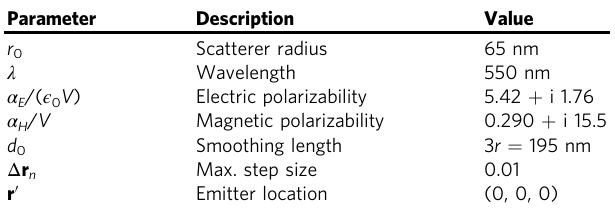
Fig. 1 The system considered in our numerical examples. A schematic of the problem is shown in ( a ). A dipole emitter with polarisation ^ p is located at r ′ . This generates source fi elds ( E s , H s ), which are scattered by N silicon spheres located at r n . The scatters have optical properties shown in ( b ). The scatterers are assumed to be isotropic silicon spheres of radius 65 nm, with the frequency dispersion of the polarizability extracted from experimental data 57 . A simple example of the design process is shown in ( c ). The power emission of the emitter (red arrow) is enhanced by iteratively moving passive scatterers (black dots). Colour plots show Im ½ E ð r Þ (cid:5) ^ p (cid:3) , which evaluated at the emitter ’ s location is proportional to power emission. The enhancement of this quantity at the location of the emitter is Fig. 2b. The initial and fi nal eigenmodes and eigenvalues are Table 1 Parameters used for all numerical calculations. shown in Fig. 2c, d. It can be seen that the eigenvalues of the modes change very little as the optimisation process progresses.